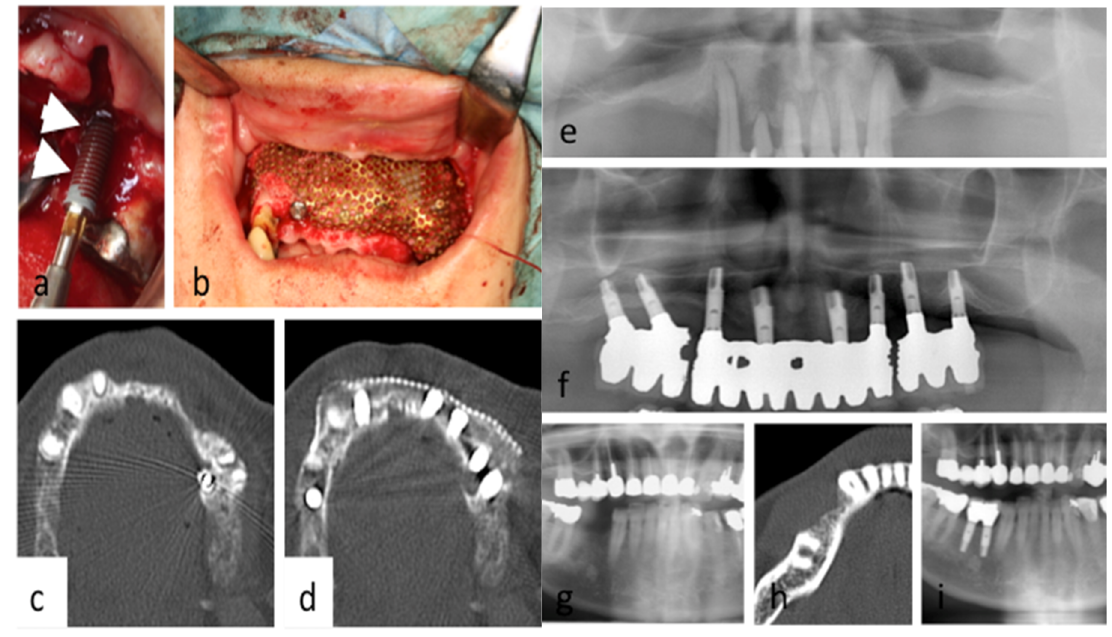
Figure 2. ( a ) Photofunctionalized implant attracts blood. ( b ) Simultaneous bone augmentation with PCBM and titanium mesh in atrophied maxilla. Computed tomography before ( c ) and after ( d ) placement with simultaneous bone augmentation ( a – d ; Pt.No.7). Orthopantomography before implantation ( e ) and after prosthesis ( f ) (Pt.No.4). Orthopantomography ( g ) and computed